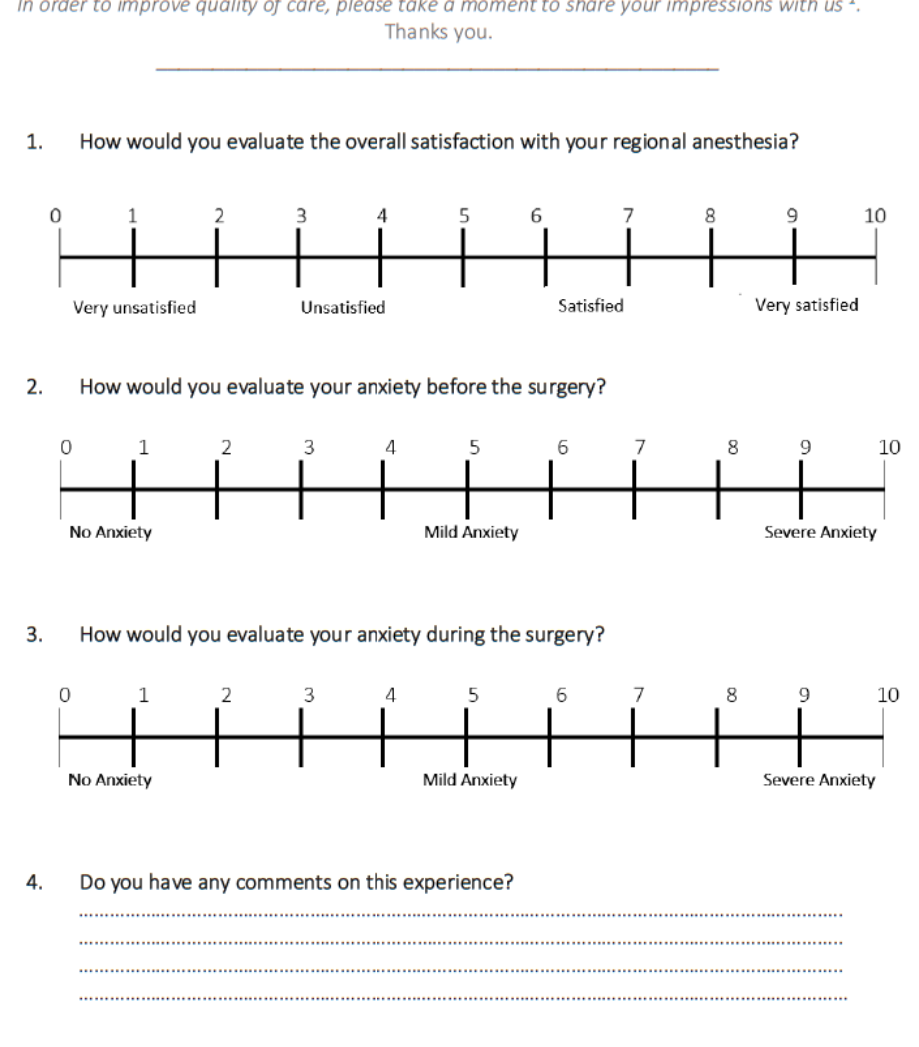
Figure A2. Postoperative satisfaction